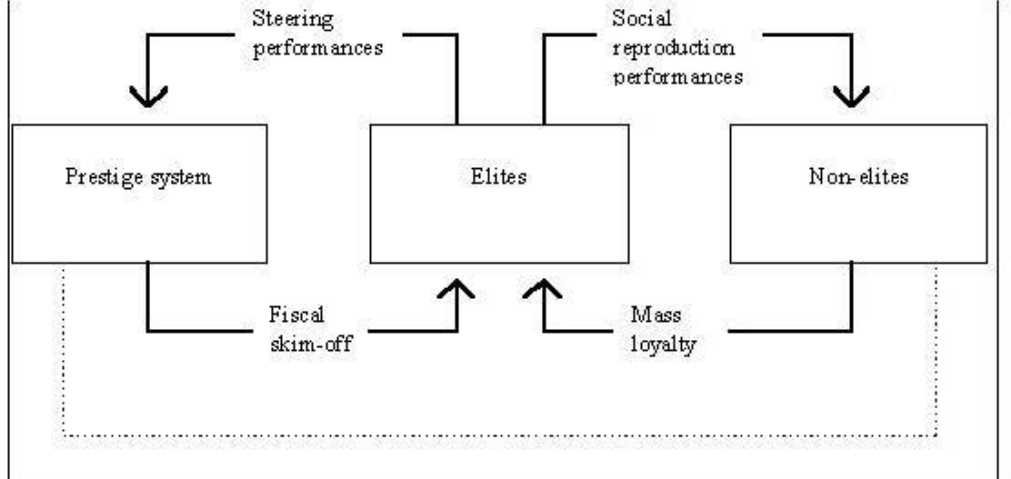
Fig11re 1. Habcnnas's conception of socio -political organization r,.,'\-iscd to fbc,,is on social